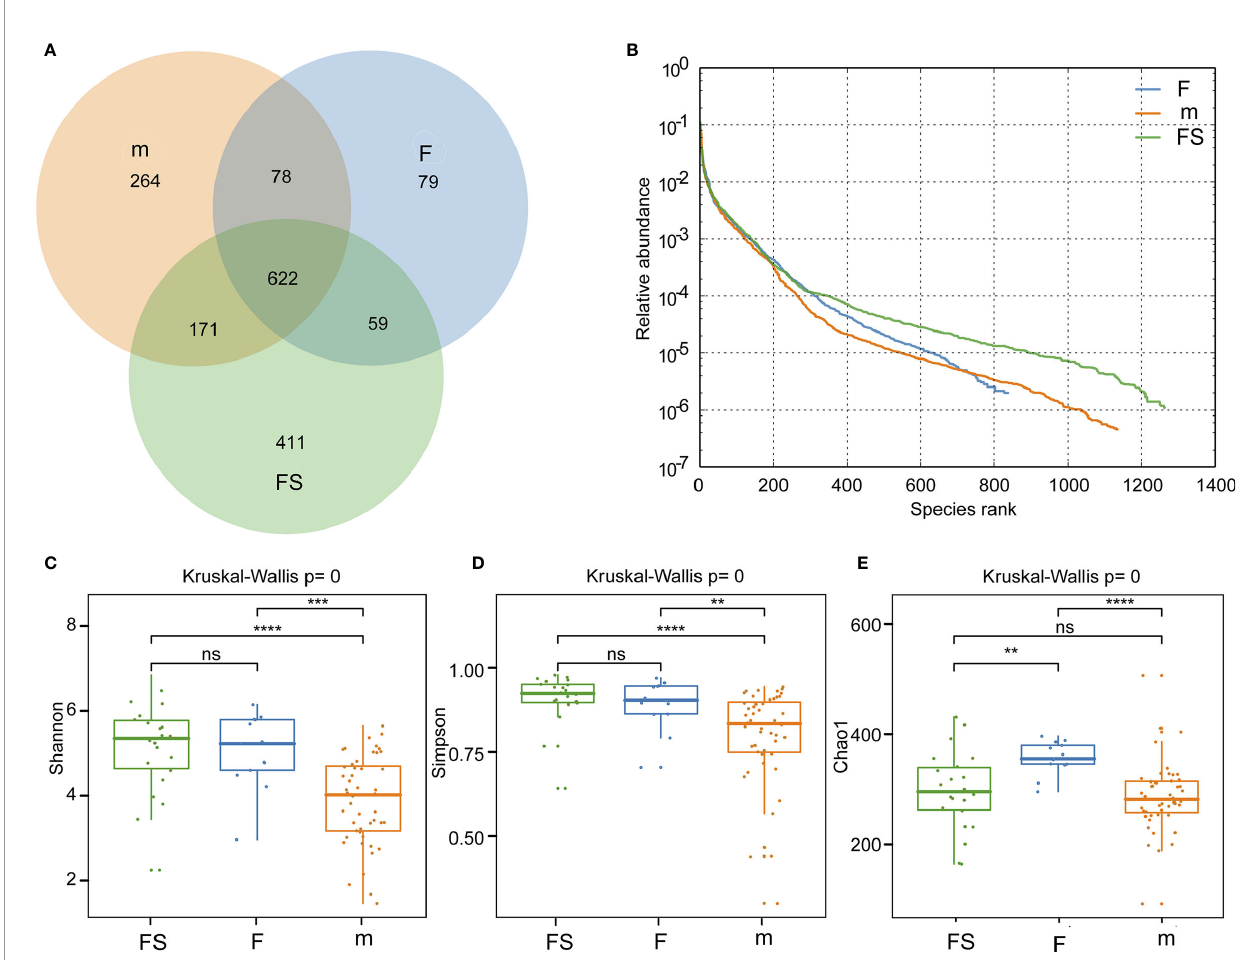
FIGURE 2 | Analysis of gut microbial diversity. (A) Common and unique number of OUTs in the three groups. (B) Rank abundance curve of the three groups. (C) Community richness analysis by Chao 1 index. (D) Community diversity analysis by Shannon index. (E) Community diversity analysis by Simpson index. fs, supplemented formula group (n = 22); f, standard formula group (n = 13); m, breastfeeding group (n = 48). **(p < 0.01); ***(p < 0.001); ****(p < 0.0001); ns, no signi fi